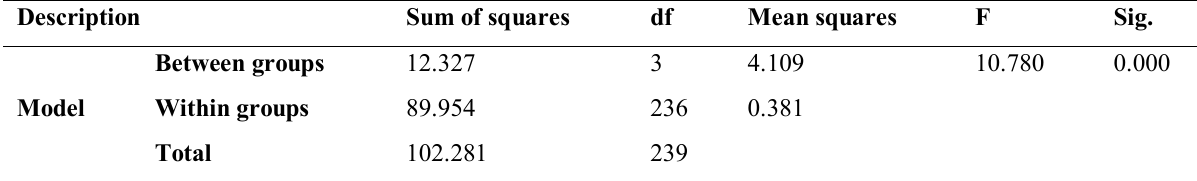
Table 13-ANOVA (Comparing the ROA of different sectors at middle investment